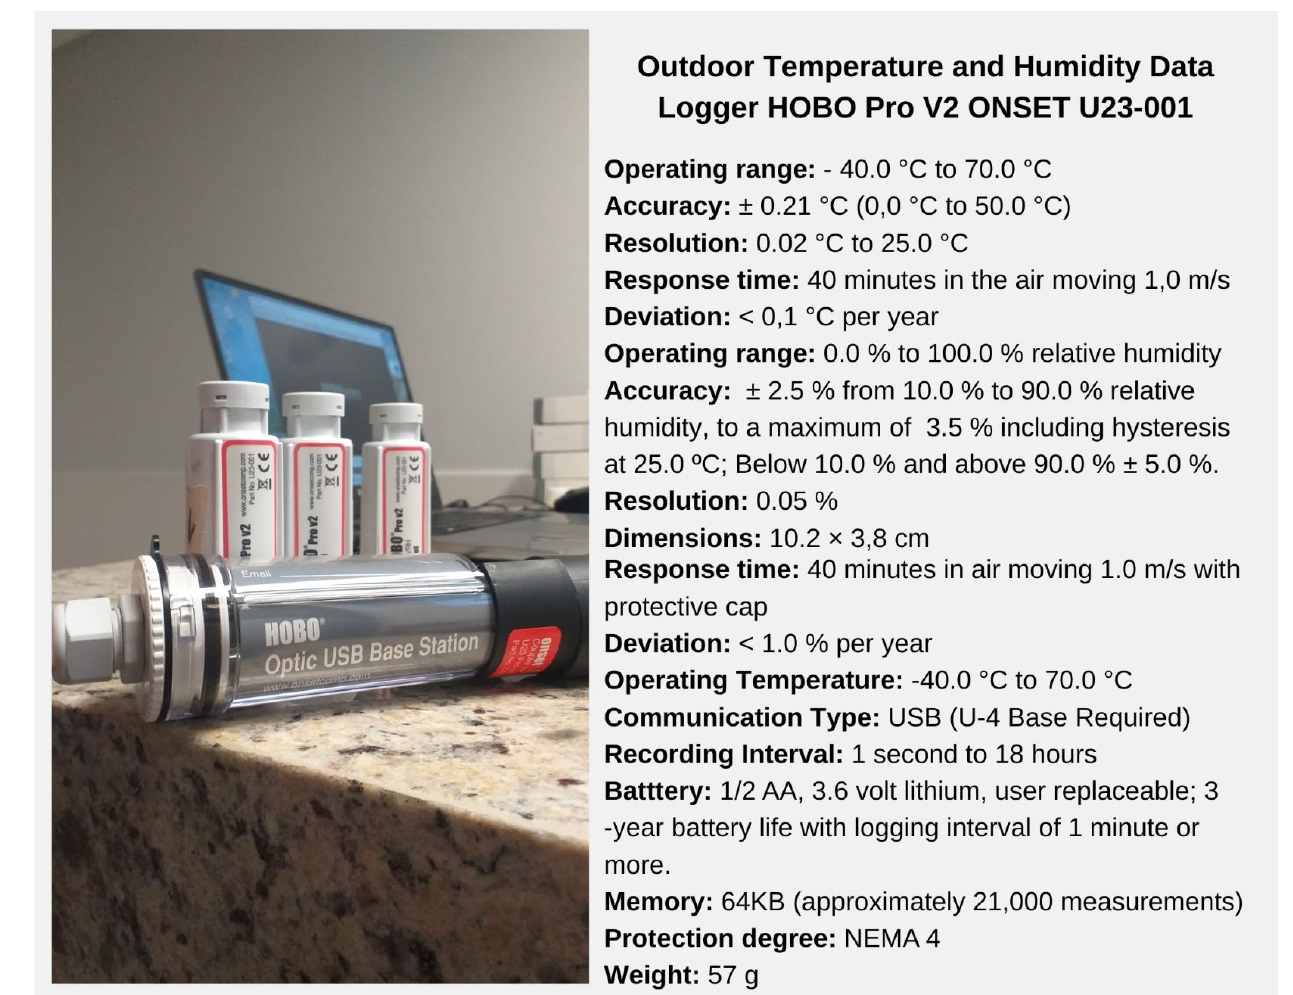
Figure 5. HOBO ® U23 ‐ 001 model dataloggers used in mobile transects. Source: Authors (2022).